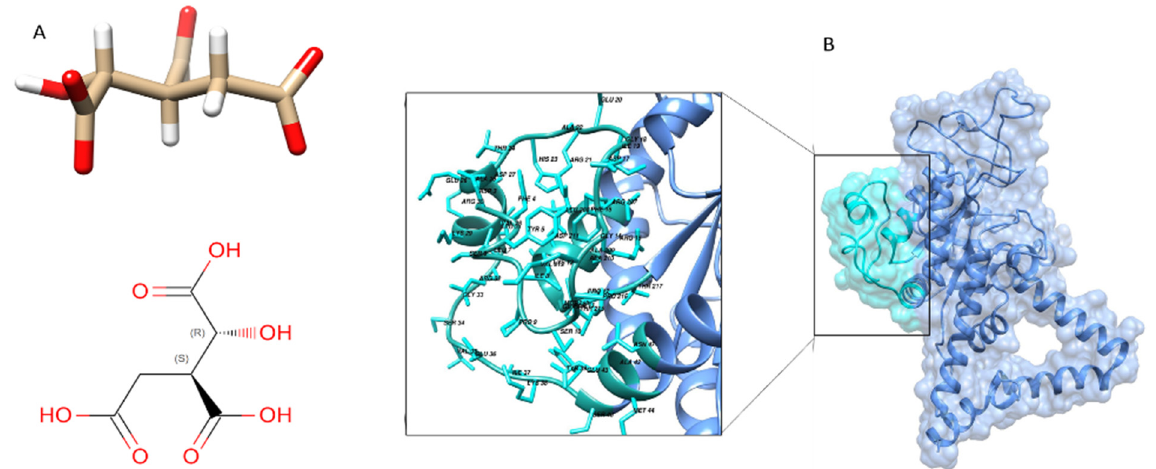
Figure 5. Ligand and active site prediction. Isocitric acid is predicted as a ligand via ProBis tool for isocitrate lyase ( A ), and the active site is predicted via MOE in isocitrate lyase protein ( B ).